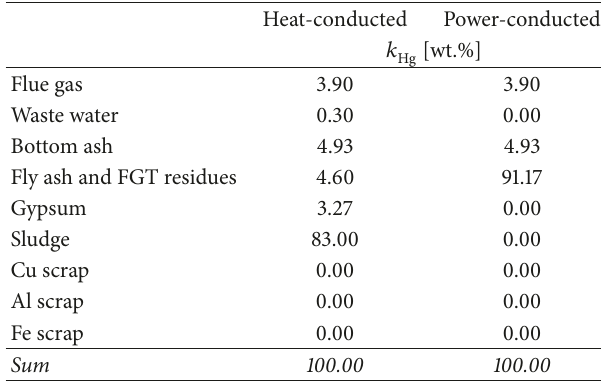
Table 2: Transfer coefficients onto the different output fractions for Hg in both